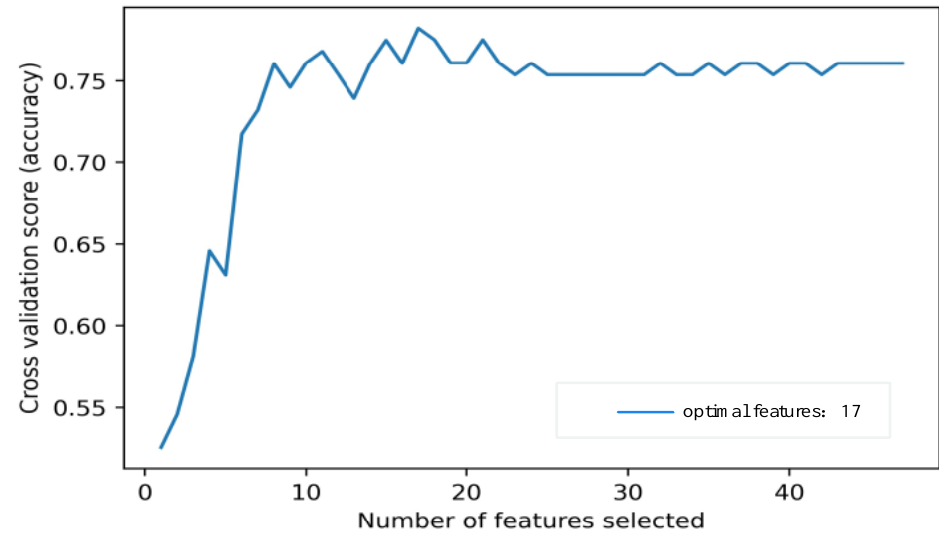
Figure 4. Cross-validation scores under different